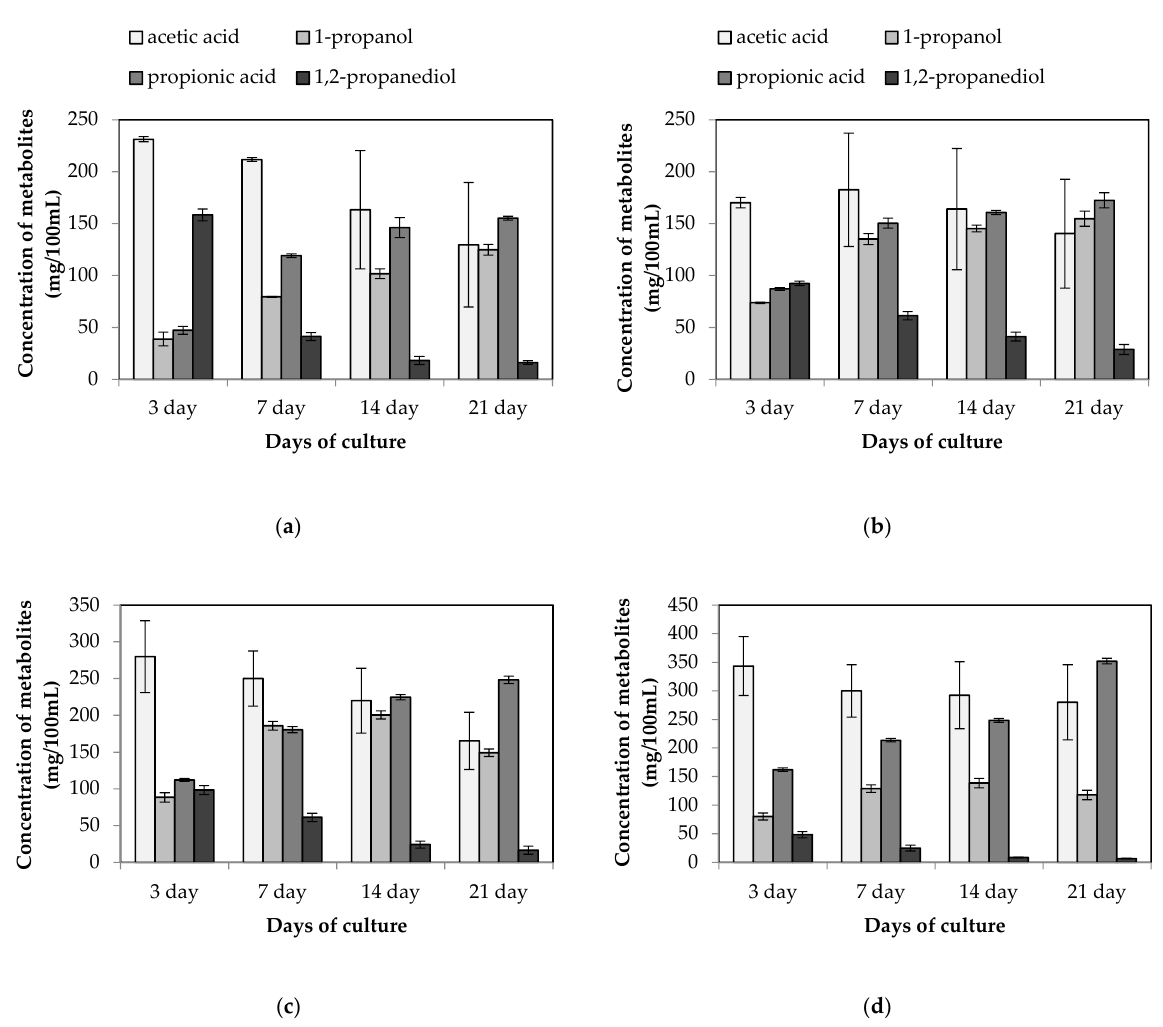
Figure 2. Metabolite profile of supernatant resulting from P. acidilactici KKP 2065p ( a – c ) culture and co-fermentation of strains L. buchneri KKP 2047p and P. acidilactici KKP 2065p ( d ) in medium containing glucose and/or 1,2-propanediol as a carbon sources ( a )–medium containing 6.0 g/L 1,2-propanediol; ( b ) medium containing 6.0 g/L 1,2-propanediol and 5.0 g/L glucose; ( c , d ) medium containing 8.0 g/L 1,2-propanediol and 5.0 g/L glucose. There was showed a standard deviation for each measurement.